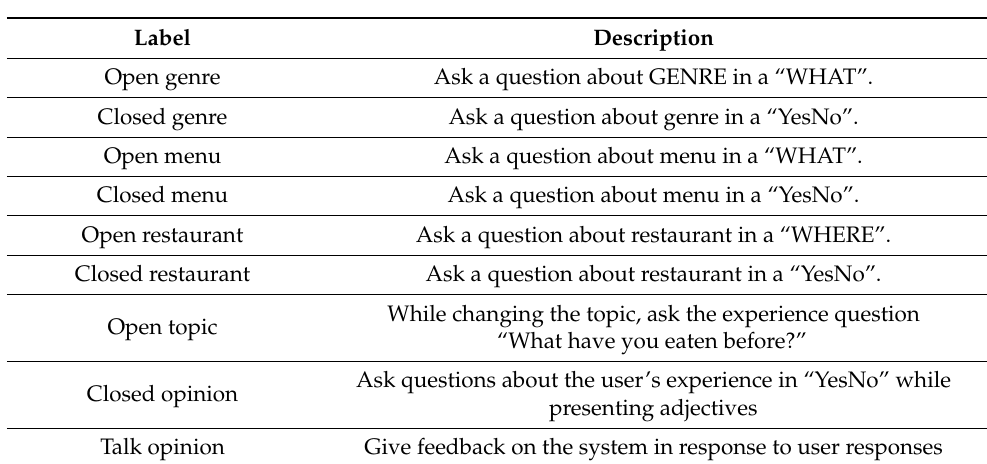
Table 2. Type of utterance.